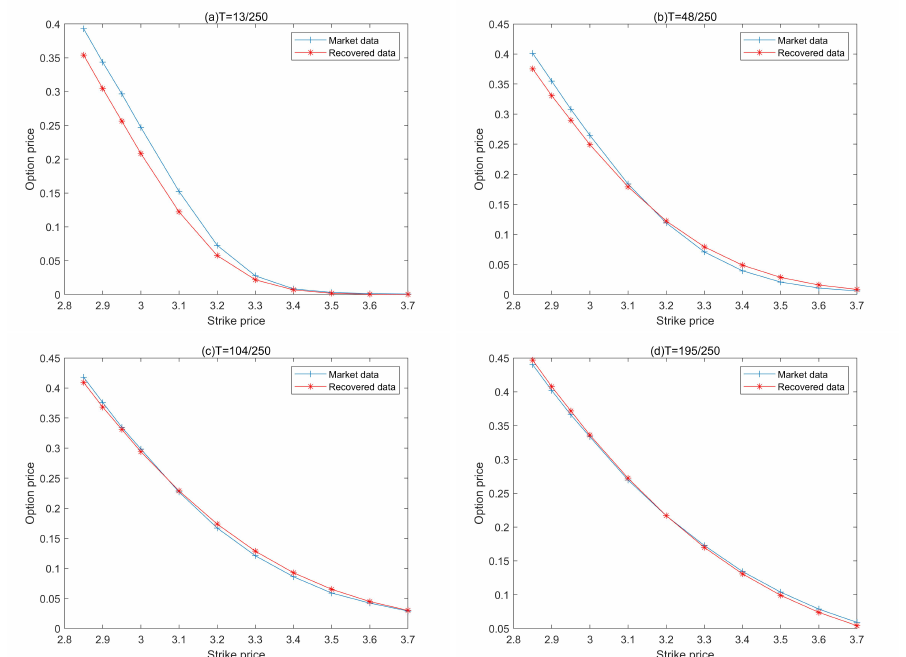
Figure 6. Comparison of SSE 50ETF option price with recovered